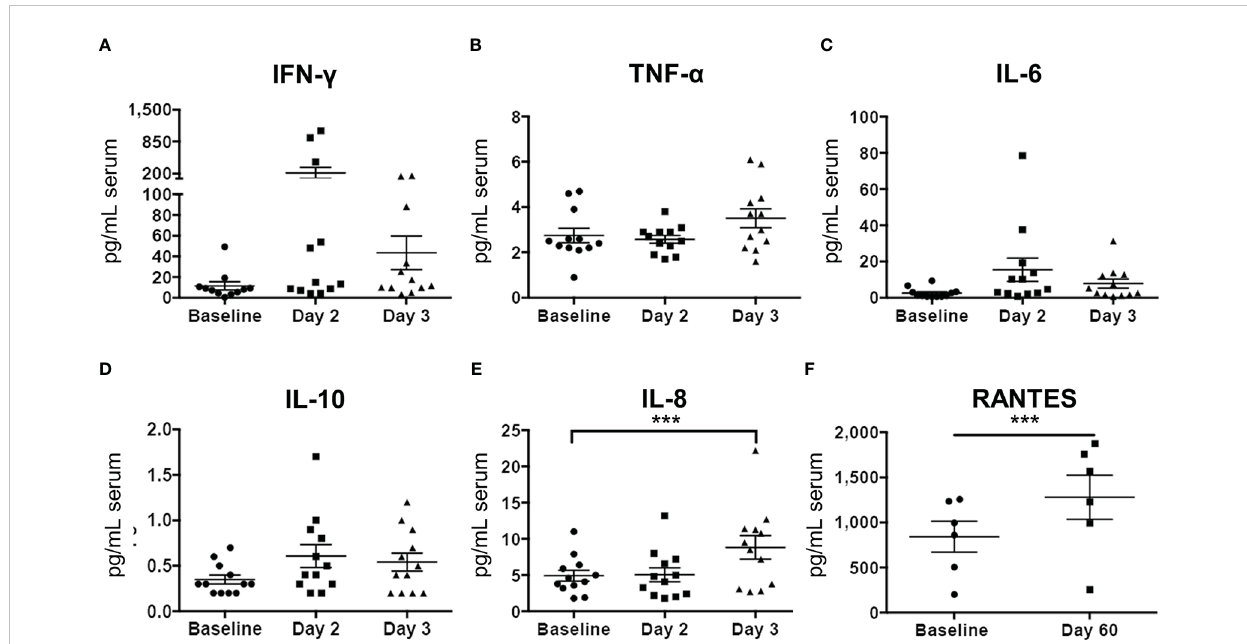
FIGURE 9 Serum cytokine pro fi les before and after Olvi-vec therapy. (A – F) Serum sampled before and after Olvi-vec therapy (at Day 2, Day 3, and Day 60) was evaluated for concentrations of cytokines. Bars indicate mean and SEM. ***p<0.01, paired t-test.